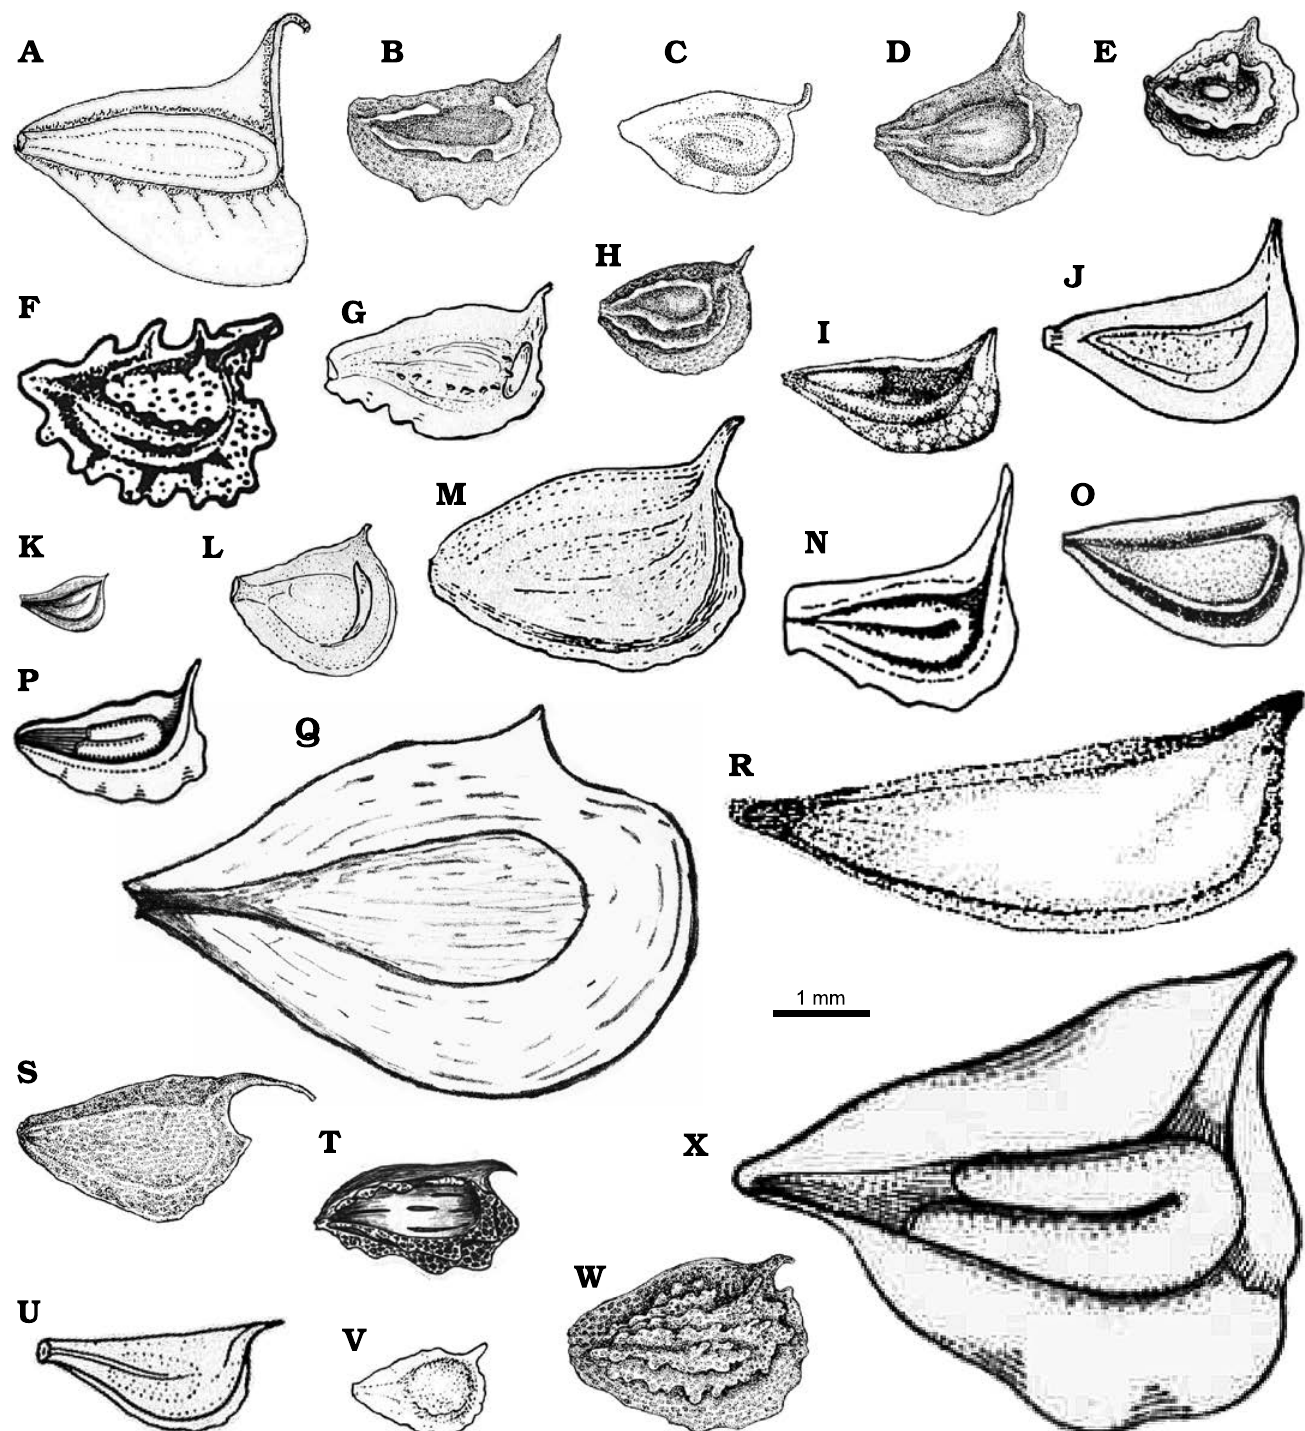
Fig. 5. Illustrations of species detailed in Table 2. A . Sagittaria montevidensis ssp. calycina (Ricketson 2018) ( S. calycina following Keener 2005). B . Sagittaria cristata (Wooten 1973). C . Sagittaria demersa (Smith 1895). D . Sagittaria fasciculata (Wooten 1973). E . Sagittaria graminea ssp. gram- inea (Haynes and Holm-Nielsen 1994). F . Sagittaria guayanensis (Rataj 1970). G . Sagittaria intermedia (Haynes and Holm-Nielsen 1994). H . Sagittaria isoetiformis (Wooten 1973). I . Sagittaria lancifolia (Matias and Irgang 2006). J . Sagittaria latifolia (Haynes and Holm-Nielsen 1994). K . Sagittaria lichuanensis (Wang et al. 2010). L . Sagittaria longiloba (Haynes and Holm-Nielsen 1994). M . Sagittaria macrophylla (Haynes and Holm-Nielsen 1994). N . Sagittaria montevidensis ssp. montevidensis (Rataj 1978). O . Sagittaria planitiana (Matias and Irgang 2006). P . Sagittaria platyphylla (Den Hartog 1957). Q . Sagittaria potamogetonifolia (Wang et al. 2010). R . Sagittaria rhombifolia (Matias and Irgang 2006). S . Sagittaria rigida (Wooten 1973). T . Sagittaria secundifolia (Kral 1982). U . Sagittaria sprucei (Haynes and Holm-Nielsen 1994). V . Sagittaria subulate (Haynes and Holm-Nielsen 1994). W . Sagittaria teres (Wooten 1973). X . Sagittaria sagittifolia ssp. S. leucopetala (Den Hartog 1957) ( S. trifolia following Lim